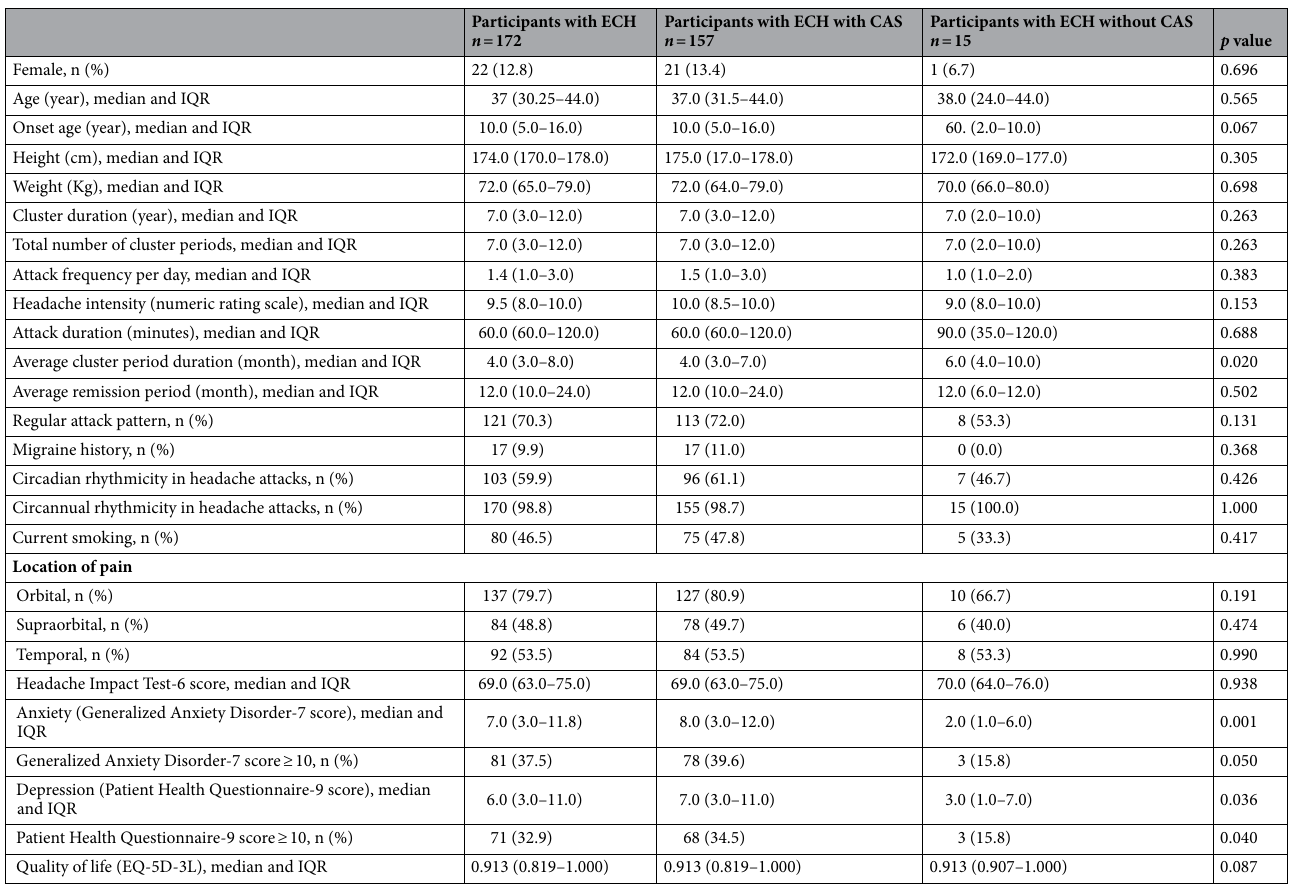
Table 4. Clinical features of participants with ECH according to the presence of CAS. CAS cranial autonomic symptoms, ECH episodic cluster headache, EQ-5D-3L the 3-level version of EuroQol five-dimension scale, IQR interquartile